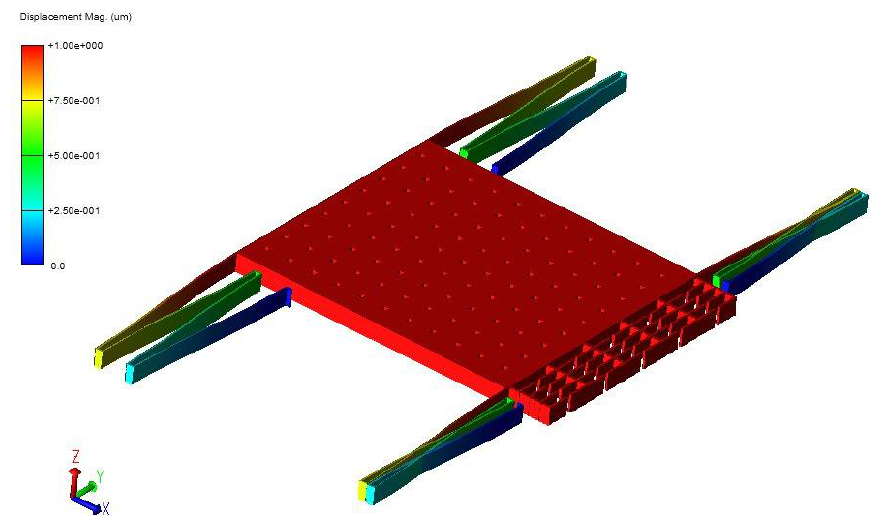
Figure 9. Finite element simulation of detection structure (double-stage beam).